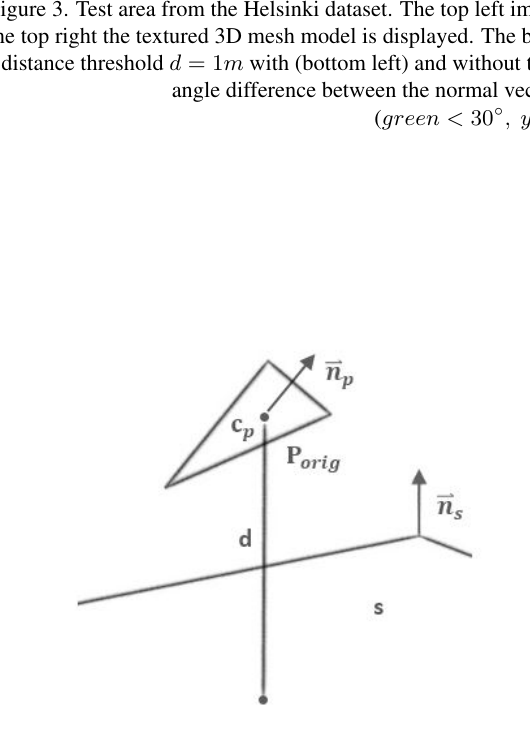
Figure 4. Point-to-plane distance d between triangle P orig and surface plane s